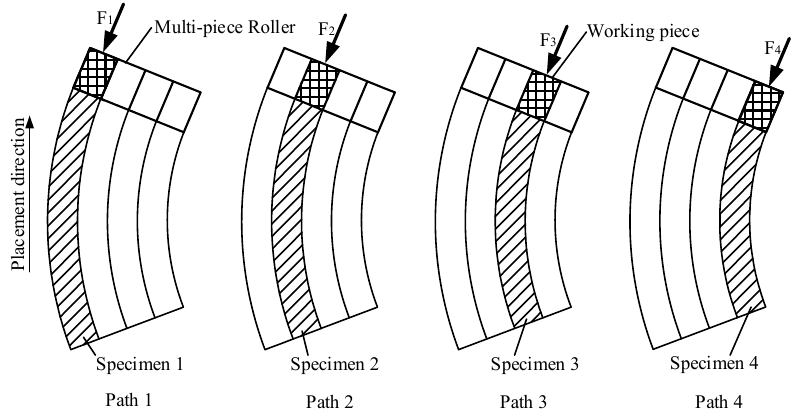
Figure 10. A schematic diagram of the laying paths for producing specimens.